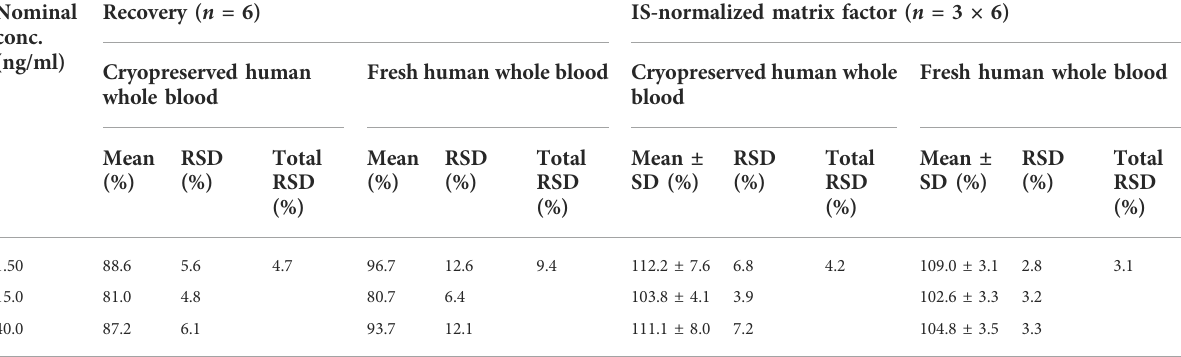
TABLE 4 Recovery and matrix effect of SRL in cryopreserved and fresh human whole blood. Nominal conc.